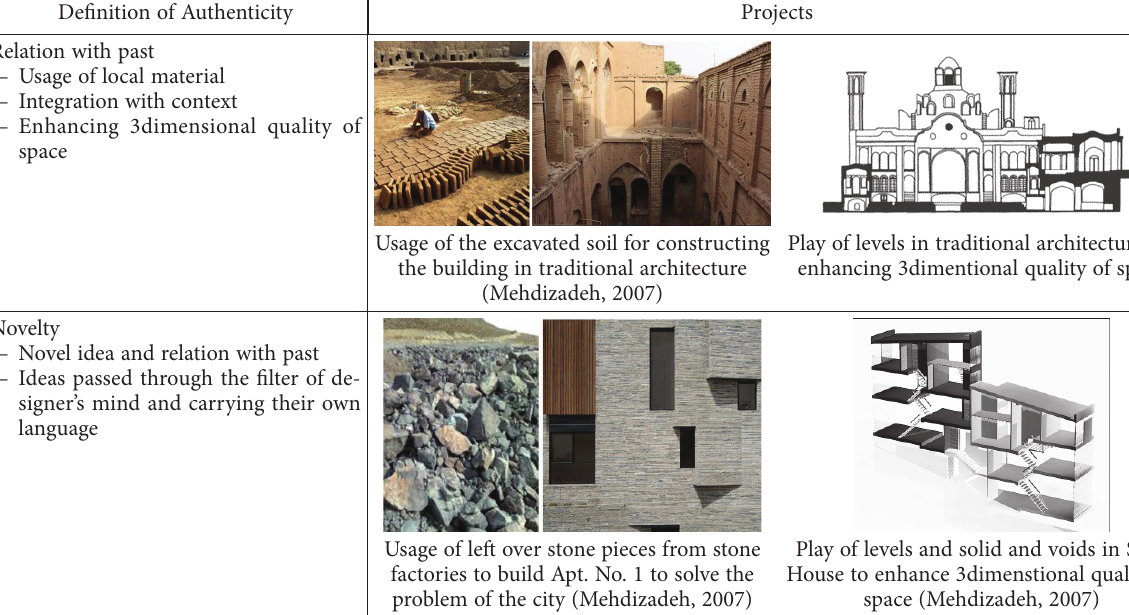
Table 5. Enhancing 3dimensional quality of space and integration with context by usage of local materials in Mehdizadeh’s works Defi nition of Authenticity